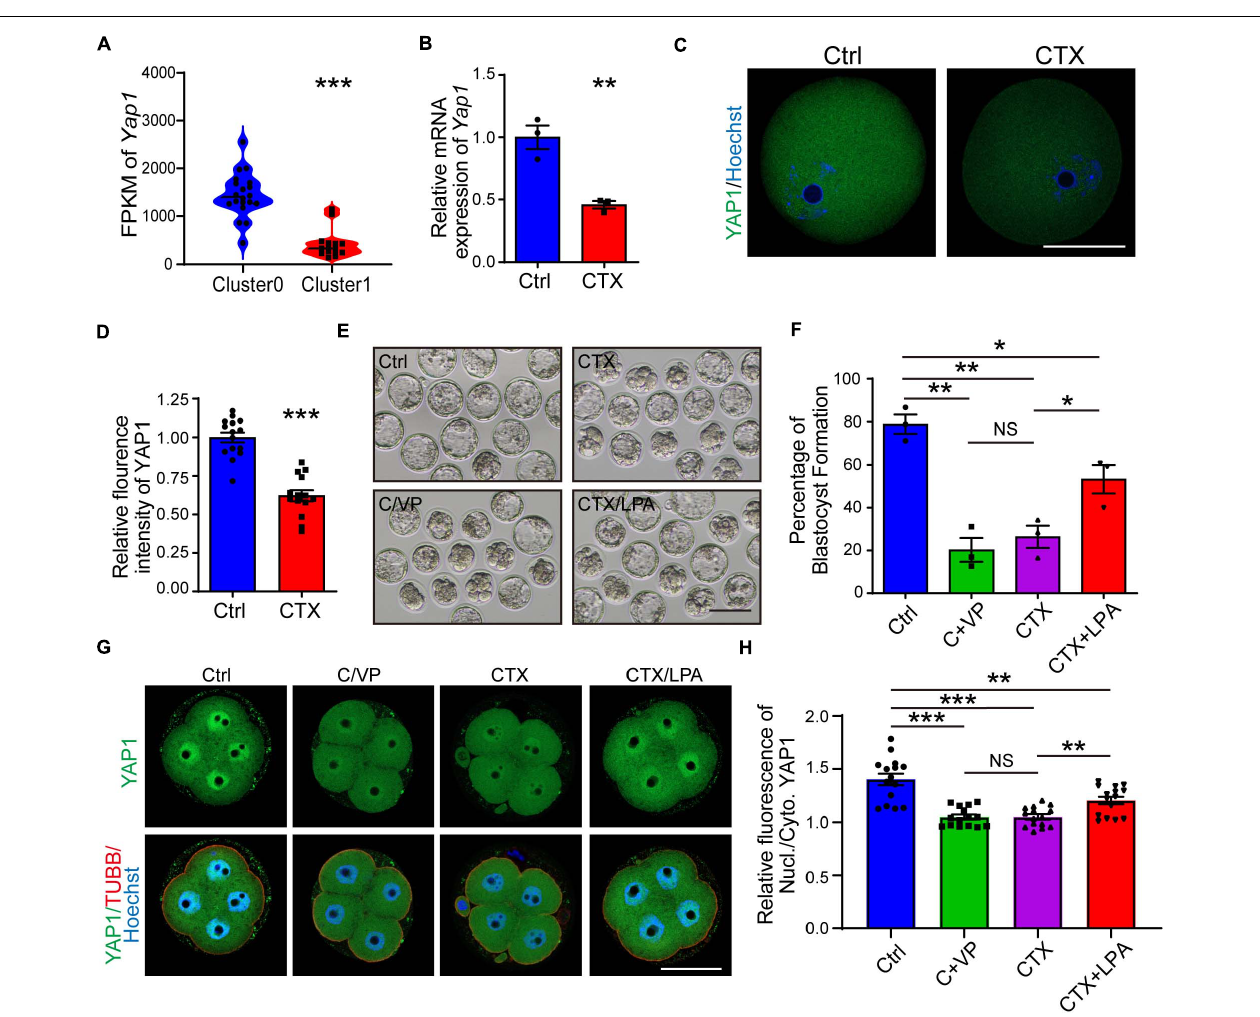
FIGURE 6 | Expression of YAP1 and its role in embryonic development in CTX-treated oocytes. (A) FPKM level of YAP1 expression from single-cell sequencing data between two clusters of oocytes. (B) The relative mRNA expression level of Yap1 in oocytes among groups. (C) Immunofluorescence of YAP1 in GV oocytes collected from mice in the CTX group. Scale bar = 50 µ m. (D) Relative fluorescence intensity analysis of YAP1 in oocytes. (E) Representative images of blastocyst formation in the four culture groups. Ctrl, Control; C/VP, control + VP; CTX, cyclophosphamide; LPA, lysophosphatidic acid. Scale bar = 100 µ m. (F) Comparable analysis of the four embryo culture compositions in (D) . Data was expressed as mean ± SEM. (G) Localization of YAP1 in four-cell embryos in four groups of (D) . (H) Relative immunofluorescence of YAP1 signals in the nucleus versus in the cytoplasm. TUBB, beta-tubulin, Nucl, nucleus; Cyto, cytoplasm. Scale bar = 50 µ m. 50, * P < 0.05, ** P < 0.01, *** P <